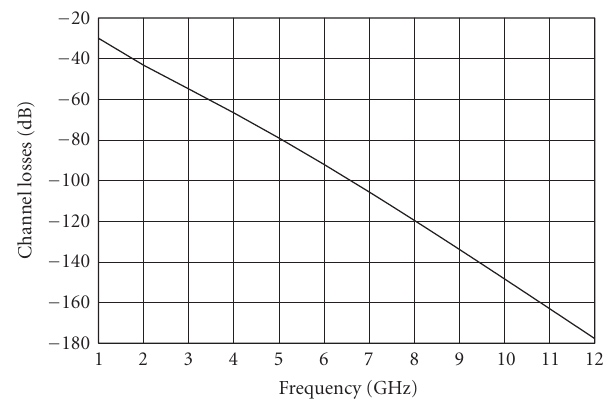
Figure 5: Channel loss versus frequency predicted by the near-field- based